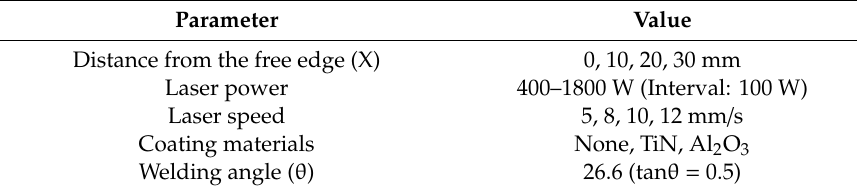
Table 2. Process parameter values for free edge